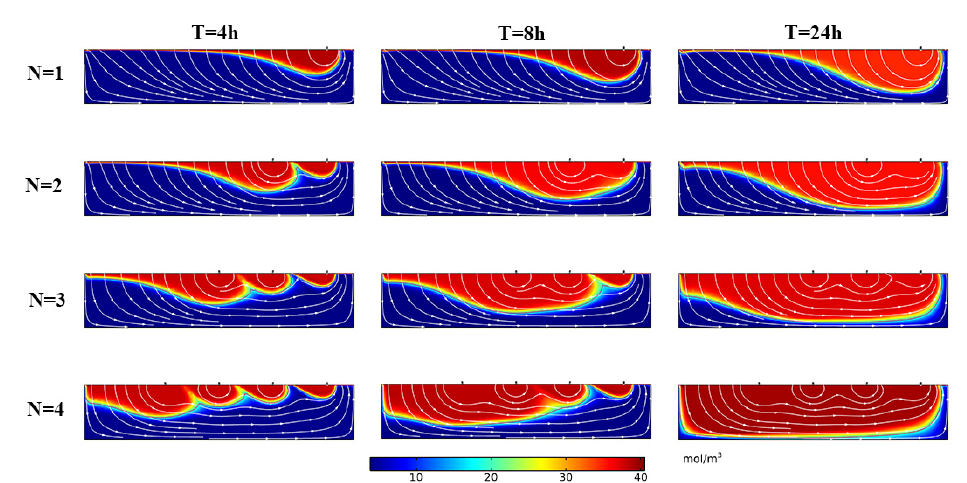
Figure 10. The distribution of solute concentration in the hyporheic zone under the influence of different structure numbers N . The color scale for the outputs, representing solute concentration; warmer colors: higher concentration, cooler colors: lower concentration. Flow in the overlying water column (not shown) is from left to right. T represents time.